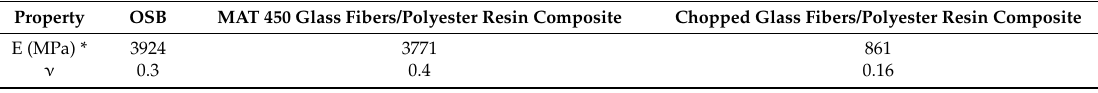
Table 3. The elastic properties corresponding to the layers of the manhole cover.